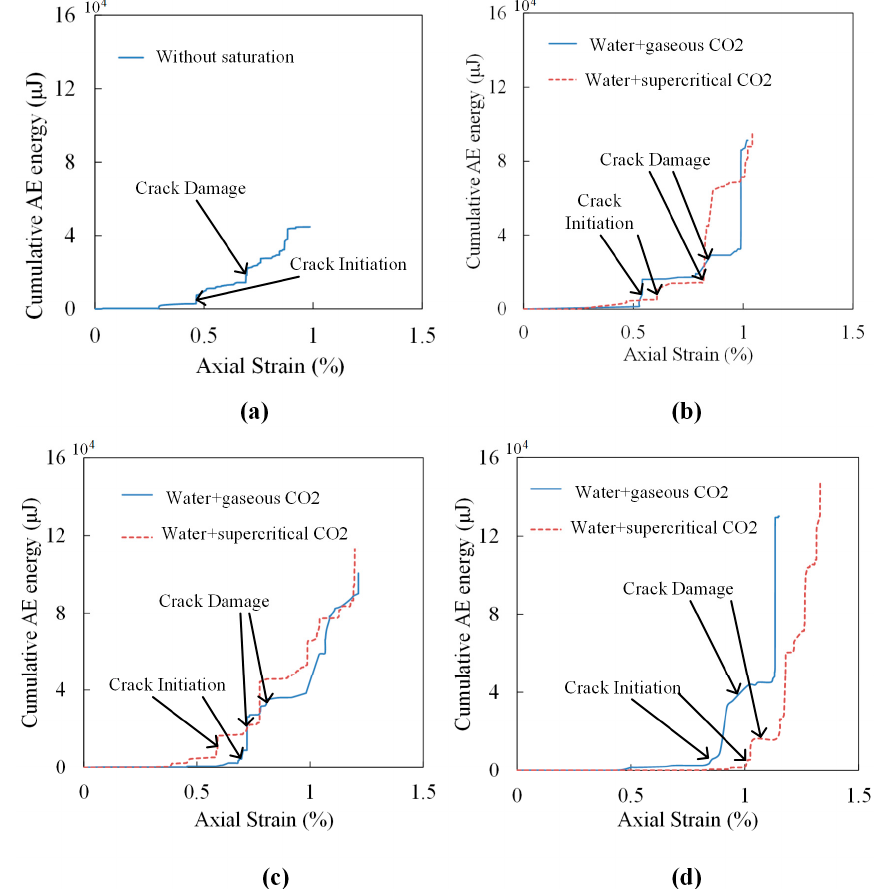
Figure 8. Variation of cumulative AE energy with axial strain for sample without saturation ( a ),